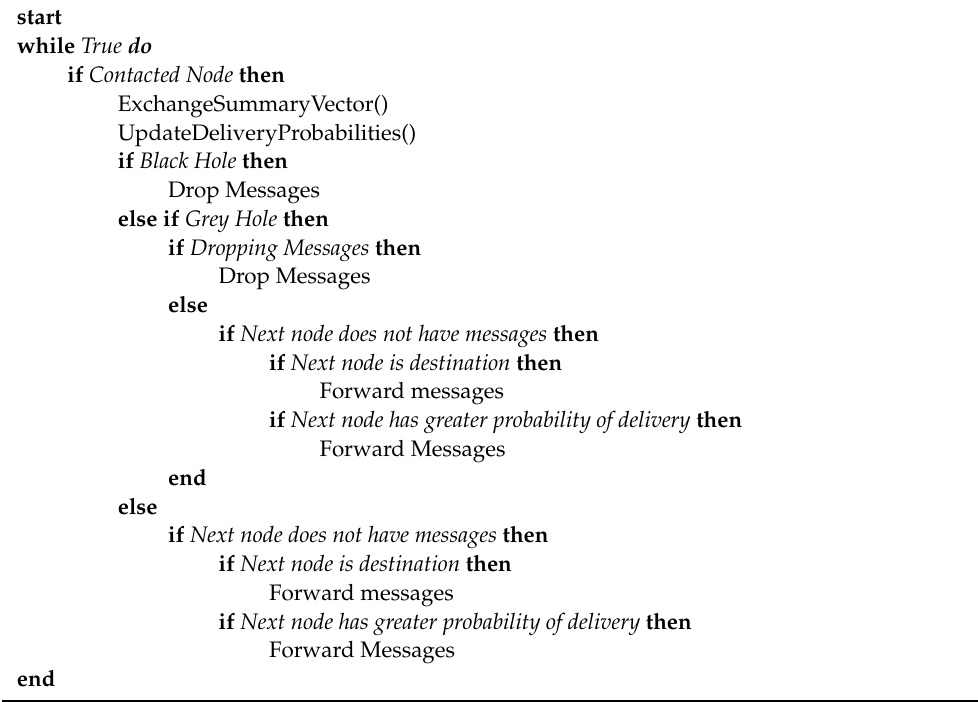
Algorithm 3. Black and Grey Hole PRoPHET